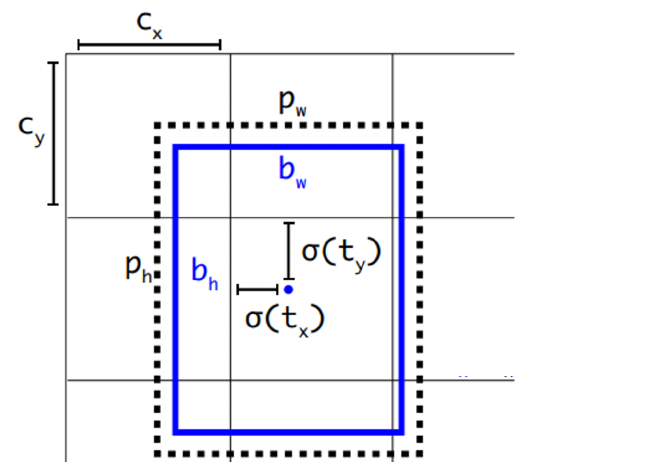
Figure 5. Bounding boxes with dimension priors and location prediction. The width and height of the box as offsets from cluster centroids and the centre coordinates of the box relative to the location of filter application are